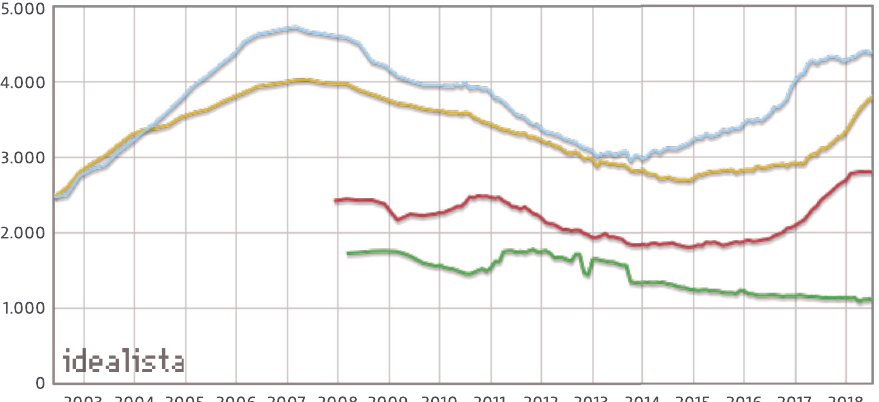
Figure 1. Evolution of the Spanish resale real estate market, focusing on four different regions: Barcelona (blue), Madrid (yellow), Palma de Mallorca (red) and Lugo (green). Source: Idealista [2], reproduced with permission from